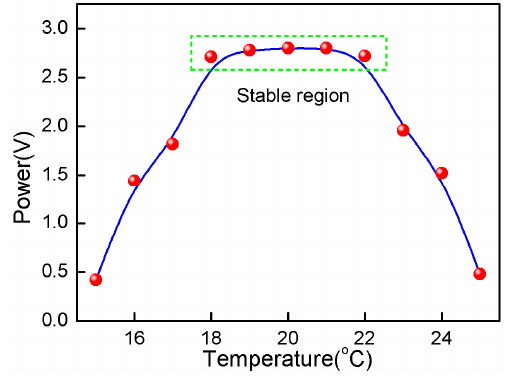
Figure 6. 300 kHz UW power versus temperature change.